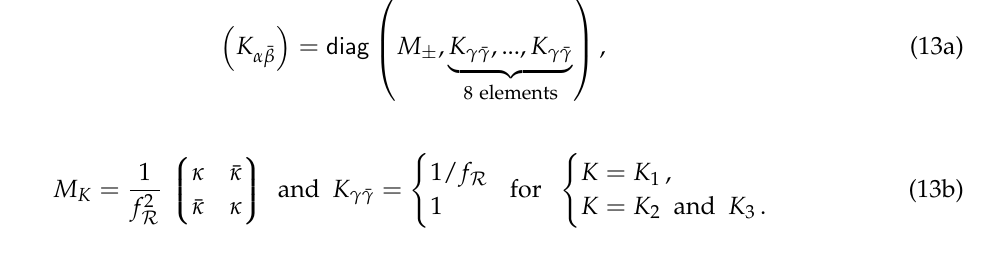
V HI as a function of φ for φ > 0, and r 10 − 3 (black line), or n = + 0.1, λ = 5.3 × (cid:98)